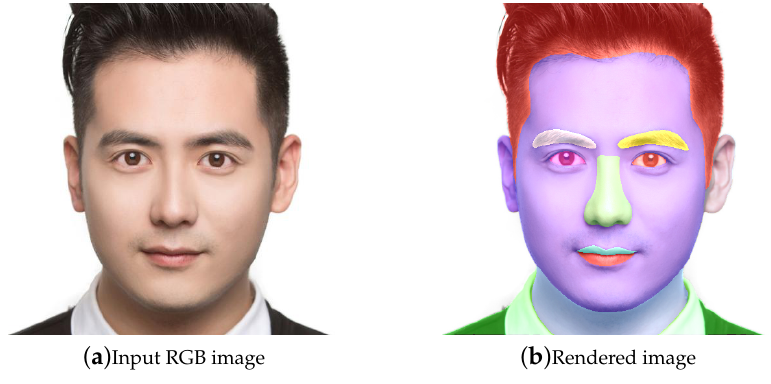
Figure 1. An example of face